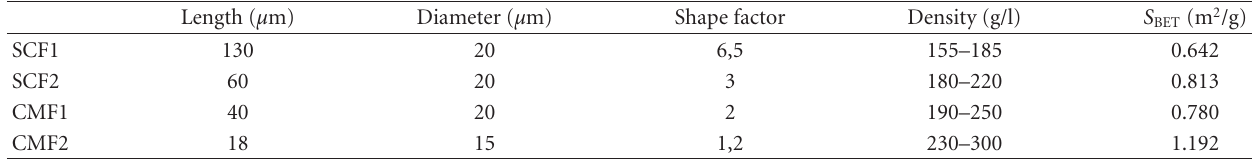
Table 15: Characteristics of the short cellulose fibres (SCF) and the cellulose microfibres (CMF) used for the study.